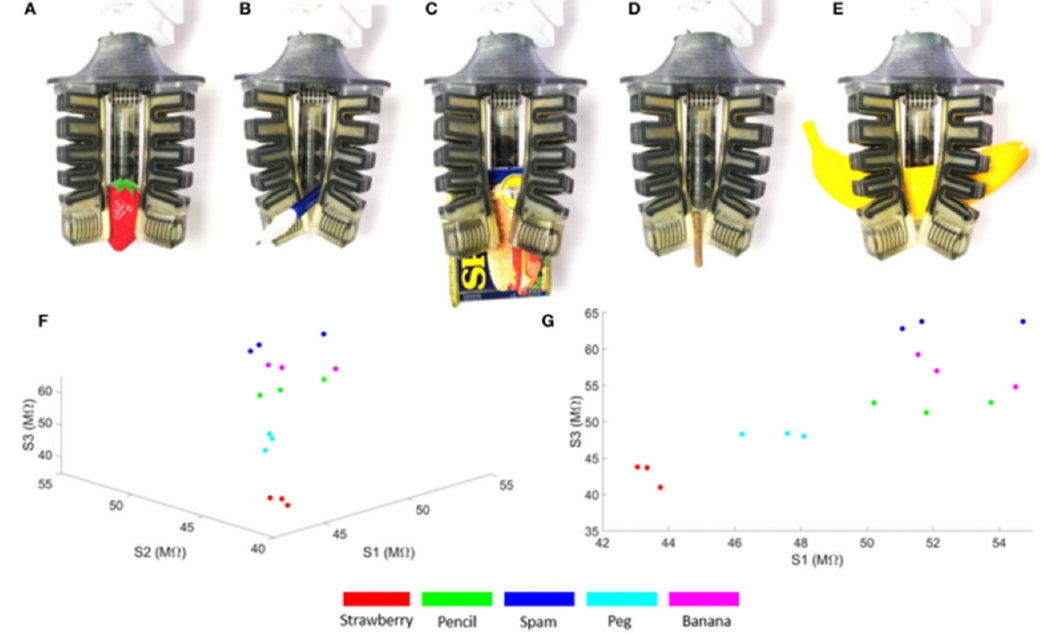
Figure 20. The effect of pressure on a semi-conductive matrix [140] (Open Access).